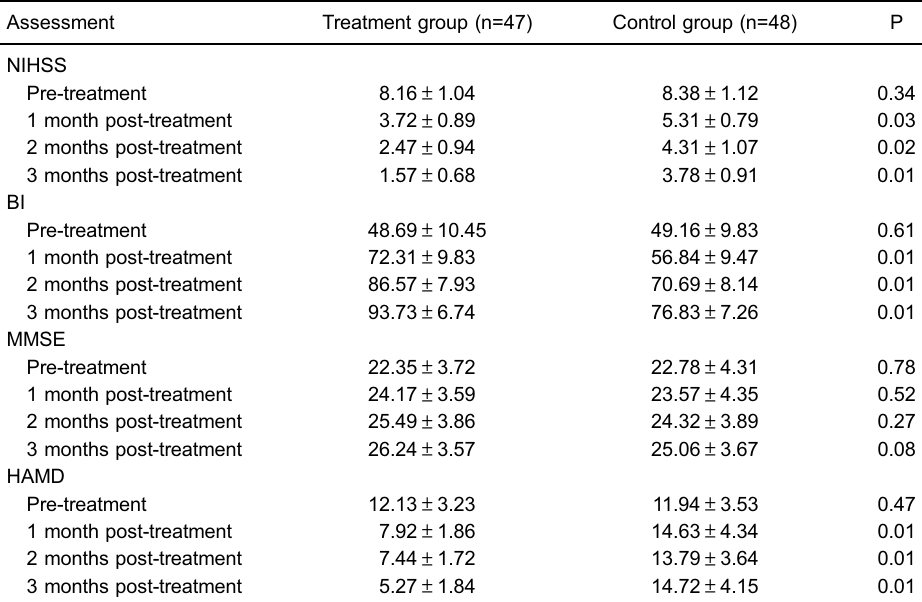
Table 1. Comparison of NIHSS, BI, MMSE, and HAMD at different time points during the follow-up of ischemic stroke patients treated or not with escitalopram.